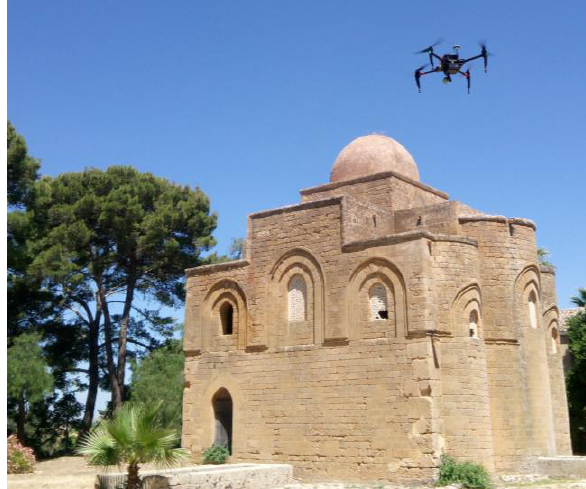
Figure 5. UAV survey for the reconstruction of the external environment.